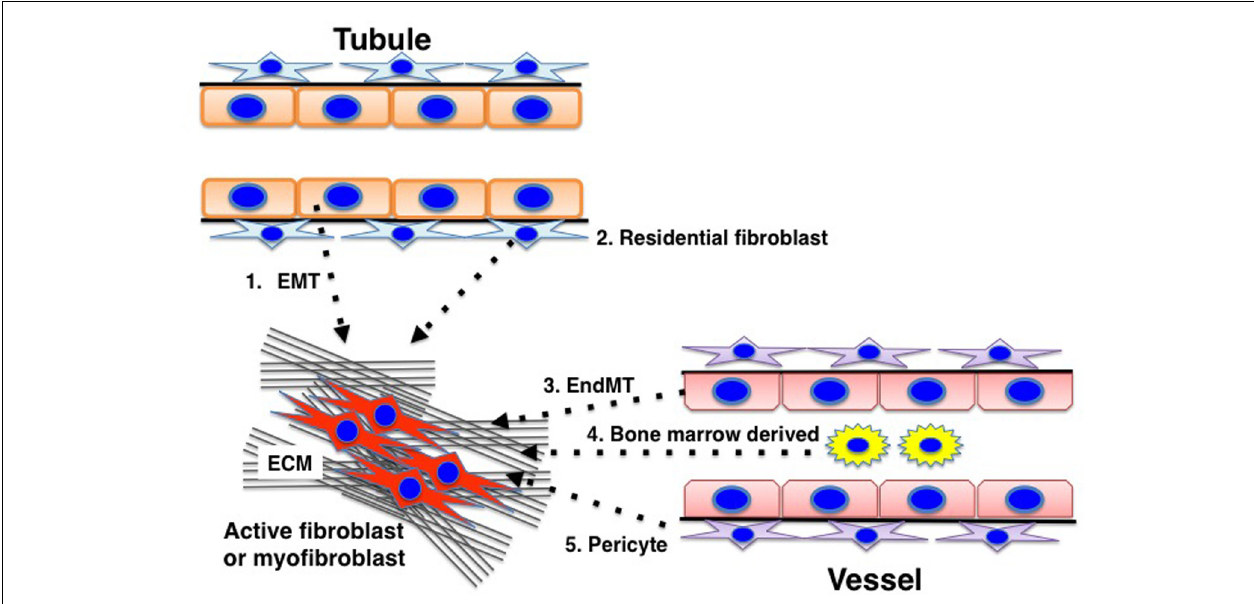
FIGURE 4 | Diverse origins of myofibroblasts. Kidney fibrosis is a well-coordinated event originating from various sources: (1) tubular epithelial cells; (2) interstitial resident fibroblasts; (3) endothelial cells; (4) bone marrow-derived cells; and (5) pericytes that contribute to myofibroblast activation/formation.